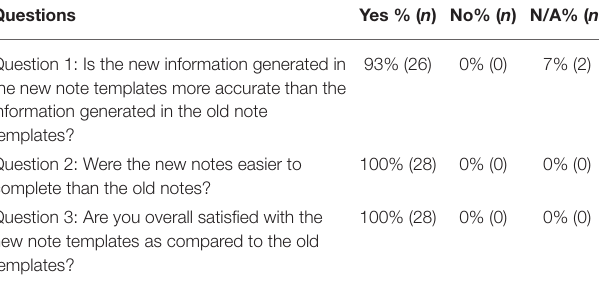
TABLE 3 | Provider survey